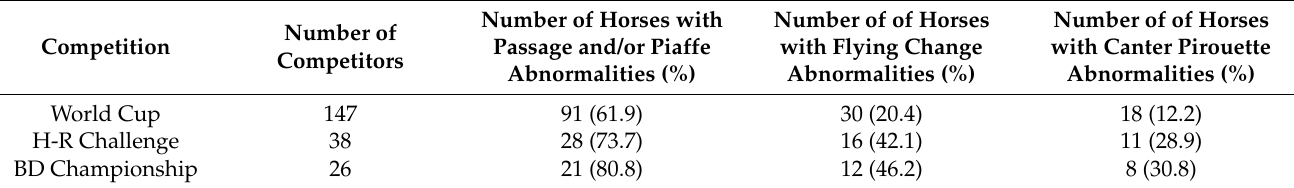
Table 4. Comparison of the frequency of occurrence (percentages, %) of gait abnormalities in passage and/or piaffe, flying changes and canter pirouettes at the World Cup Grand Prix Western League qualifying competitions ( n = 7) and the finals ( n = 2) 2018–2020 [10], the 2020 Hickstead-Rotterdam Grand Prix (H-R) Challenge and the 2020 British Dressage Grand Prix (BD) National Championship.